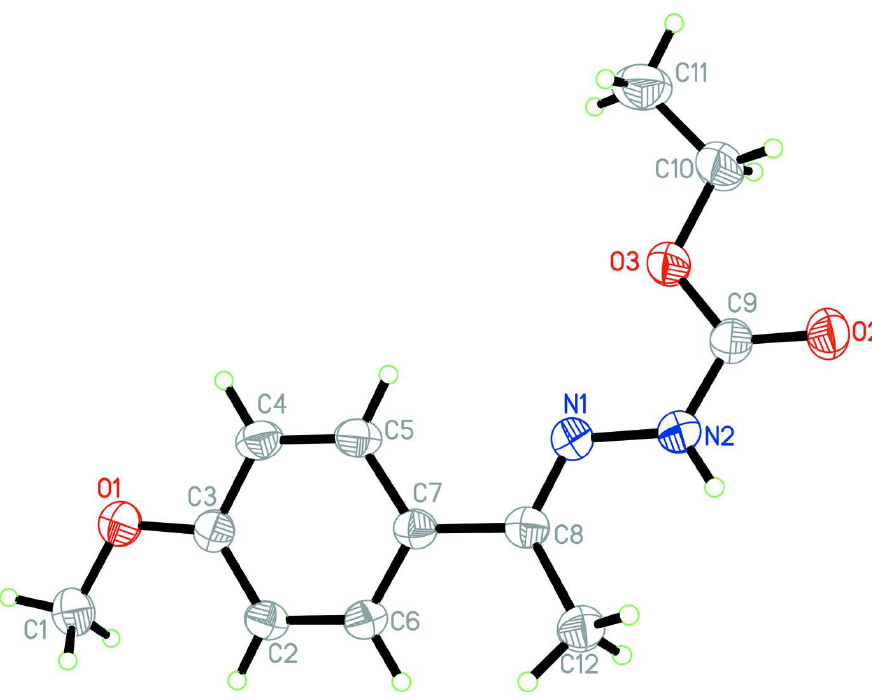
Figure 1 The molecular structure of the title compound, with the atom-numbering scheme. Displacement ellipsoids are drawn at the 30% probability level.